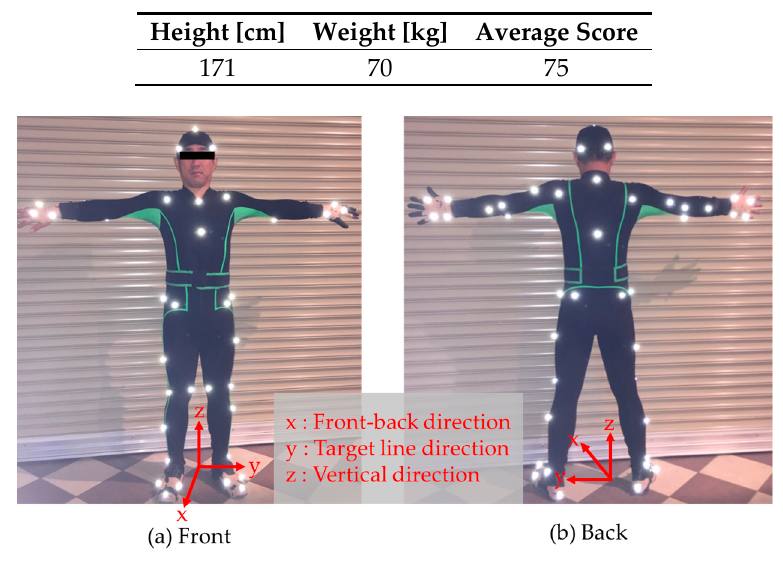
Figure 1. Locations of markers on the subject: ( a ) front, ( b ) back. The x-axis is in the front-back direction, the y-axis is along the target line, and the z-axis is in the vertical